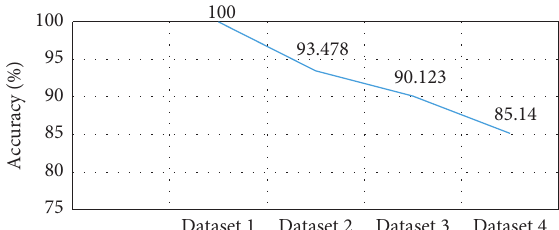
Figure 9: Datasets accuracy and challenges level